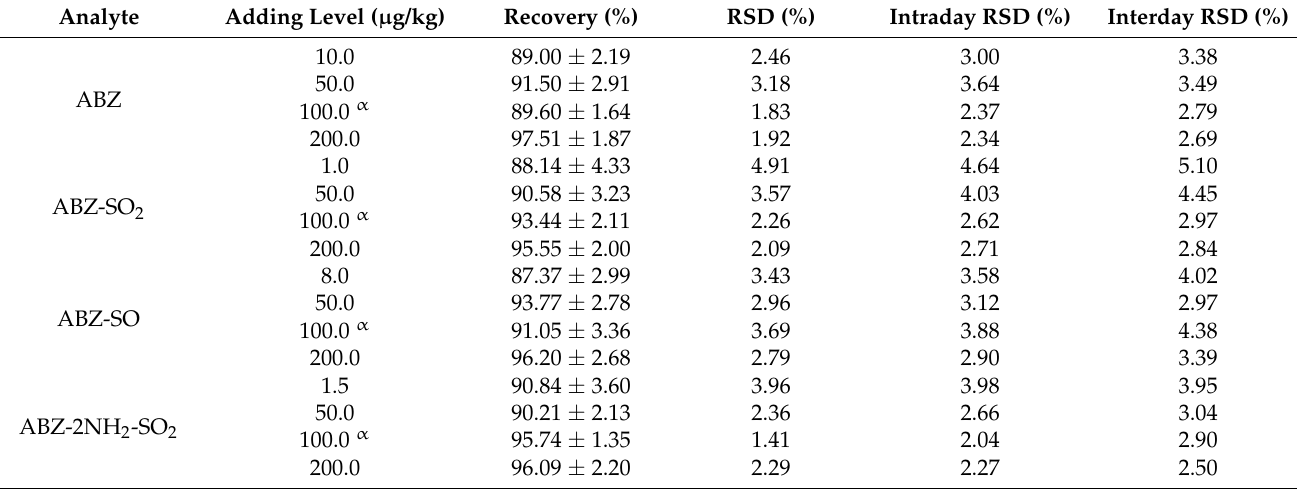
Table 5. Recovery and precision of ABZ, ABZ-SO 2 , ABZ-SO and ABZ-2NH 2 -SO 2 added to blank duck muscle (n = 6). Analyte Adding Level ( µ g/kg)